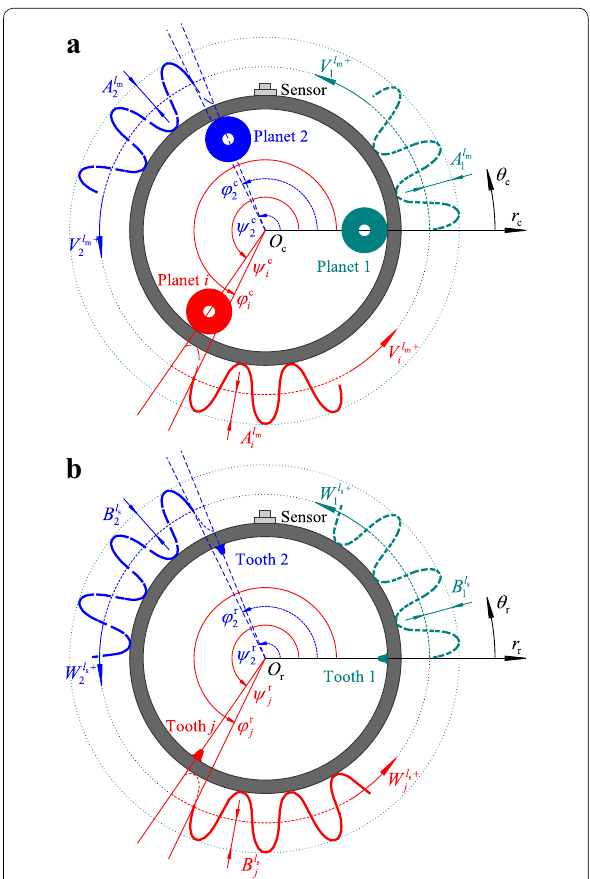
Figure 2 Elastic vibrations around helical ring gear excited by a mesh frequency excitation and b planet‑pass frequency